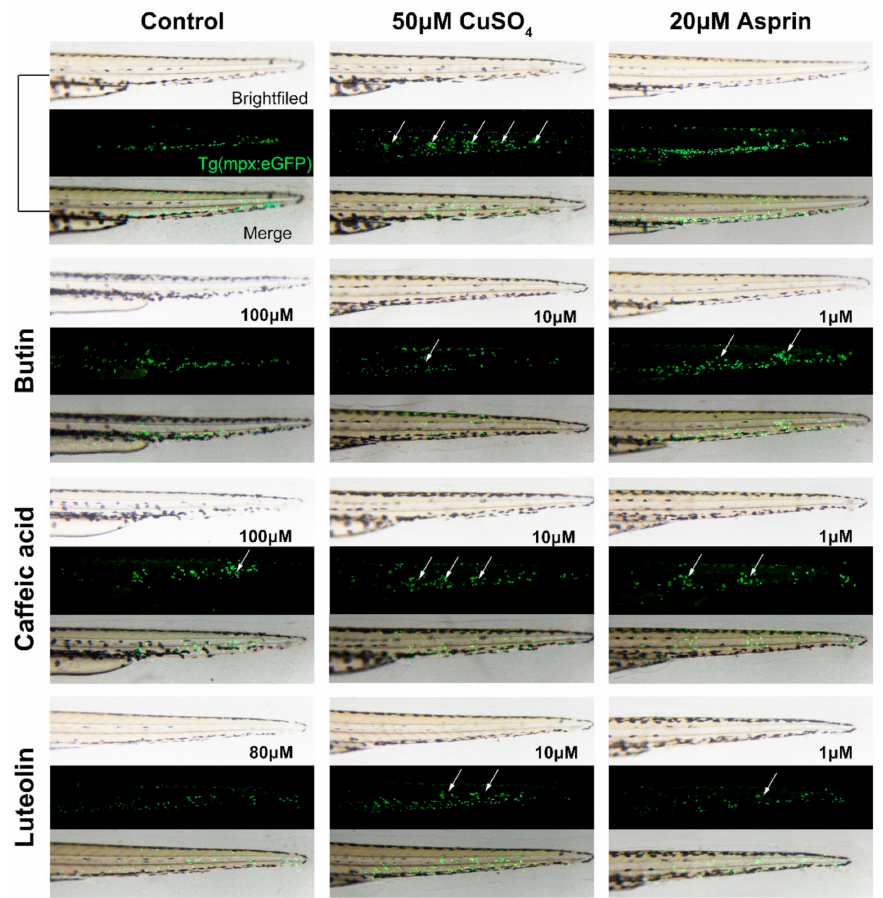
Figure 7. The anti-inflammatory effect of compounds in the chemically induced inflammation model. The time of image acquisition was when Tg( mpx:GFP ) zebrafish larvae develop to 56 hpf. Currently, transgenic zebrafish larvae exhibit green fluorescent leukocytes. Untreated fish (control) show the normal distribution of labeled cells, mostly localized in the ventral trunk and tail. In copper-treated siblings (50 µ M CuSO 4 ), leukocytes become localized preferentially to a few clusters along the horizontal midline of the trunk and tail (see white arrows); no overt tissue damage to the larvae is observed in bright-field images., and relieving inflammation by applying aspirin (20 µ M) as a positive standard. Before treated with CuSO 4 , zebrafish larvae were incubated with butin and caffeic acid [1, 10, 100] µ